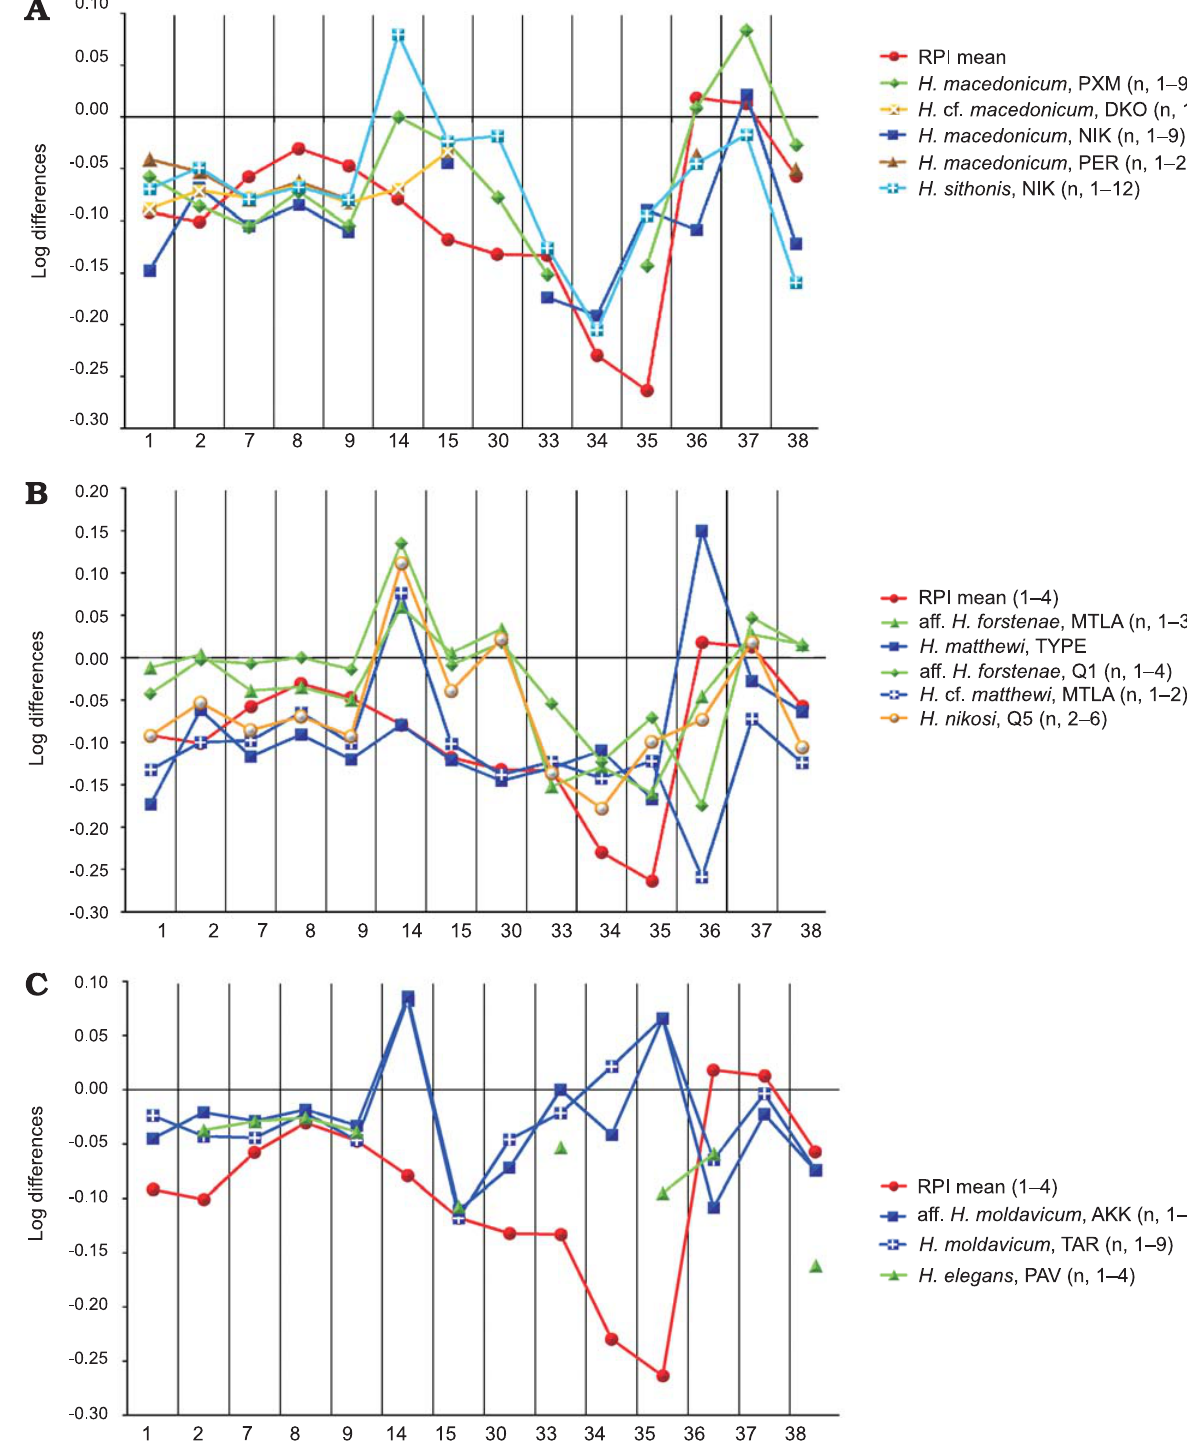
Fig. 5. Logarithmic ratio diagram comparing the RPl skull with Hipparion macedonicum and other small-sized hipparions from various localities. Hipparion mediterraneum from Pikermi (Koufos 1987a) is used as standard of comparison. The metrical data for the hipparions from Greek localities and AKK are from author’s archive; those for Hipparion moldavicum from TAR and H. elegans from PAV are taken from